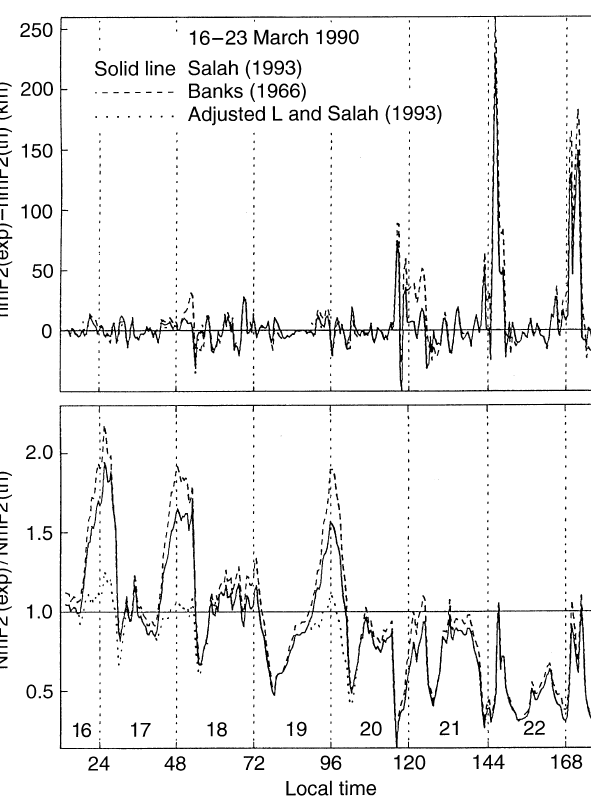
Fig. 2 . ( Top ) Differences between the measured hmF2(exp) and the modeled hmF2(th), and ratios of the measured NmF2(exp) to the modeled NmF2(th) ( bottom ) for the magnetically quiet and disturbed periods of 16–23 March 1990 for the EUVAC solar flux model. The model results were obtained using the method of Eqs. A.18, A.20 for obtaining equivalent neutral winds from the height of the F2 peak electron density with the original O (cid:135) (cid:133) 4 S (cid:134) recombination rate ( solid and dashed lines ) and when this recombination rate was decreased by the factor 1.5 during the nighttime periods 16–18 and 19–20 March with solar zenith angles more than 90 (cid:14) ( dotted lines ). The O (cid:135) (cid:255) O collision frequencies given by Salah (1993) ( solid and dotted lines ) and Banks (1966) ( dashed lines ) were used in the IZMIRAN